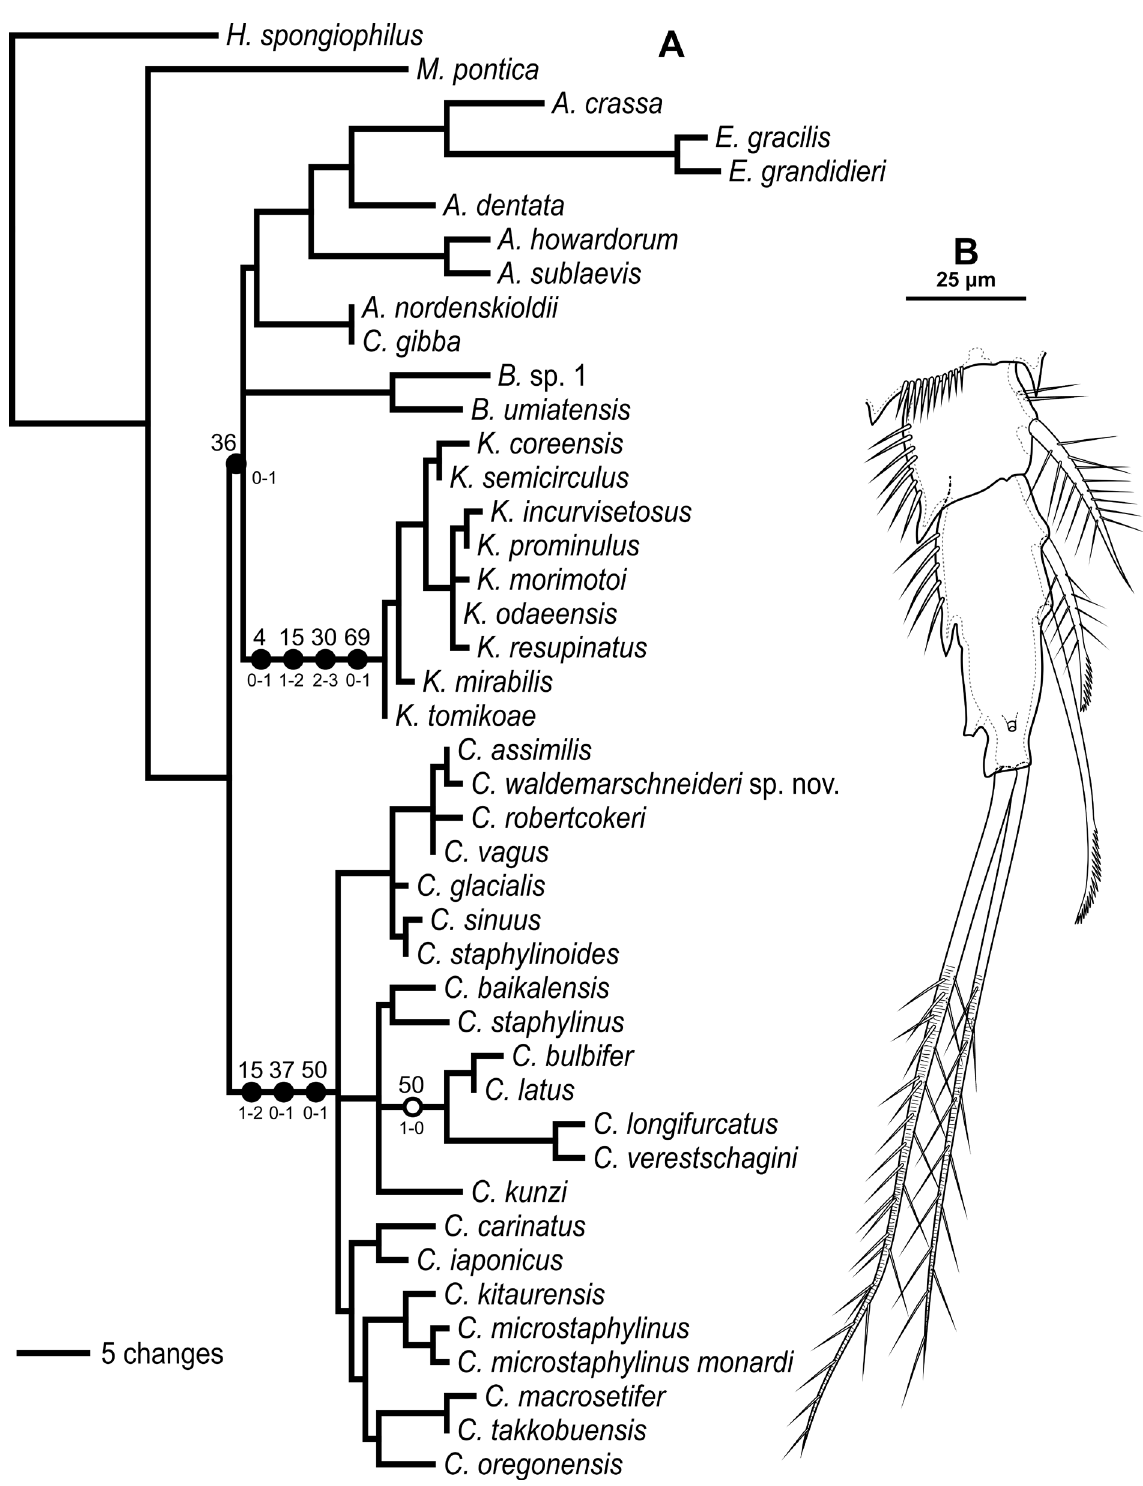
Fig. 11. A . Quartet puzzling tree of the genus Canthocamptus Westwood, 1836, constructed by the parsimony method based on the matrix from Supp. file 1 . Dots mark the main changes in character states in studied branches. Changes in the characters are marked under the dot. B . Attheyella nordenskioldii (Lilljeborg, 1902), ♂, P2 endopod. Generic abbreviations: A. = Attheyella ; B . = Bryocamptus ; C . = Camptocamptus ; E . = Elaphoidella ; H . = Heteropsyllus ; K . = Kikuchicamptus gen. nov.; M . = Mesochra